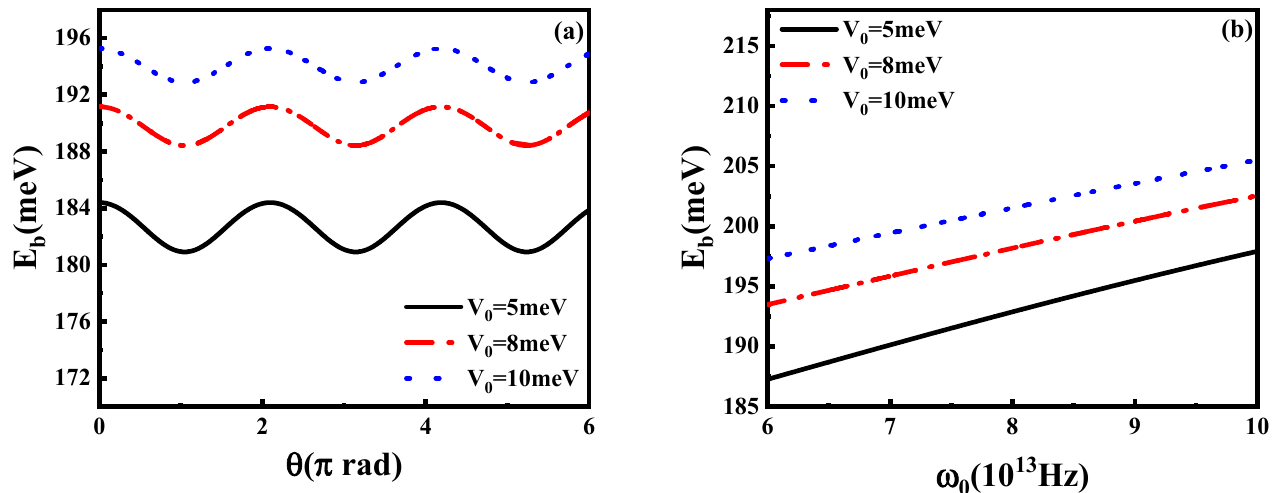
Figure 5. Ground-state energy E 0 versus ( a ) polar angle θ and ( b ) confinement strength ω 0 of a polar coordinate system.